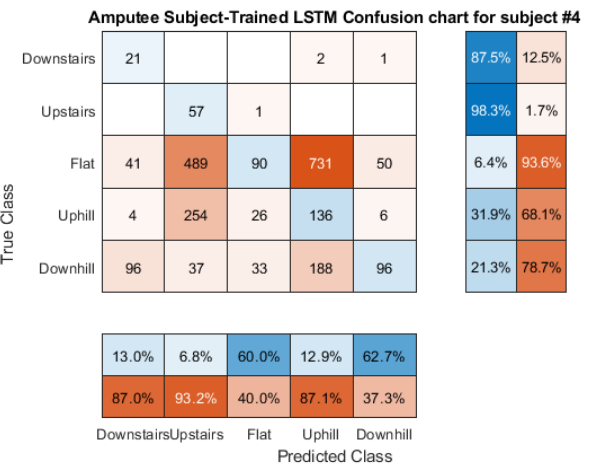
Figure A22. Long Short-Term Memory Network Confusion Chart for ILLA participant A4 as trained by all other ILLA